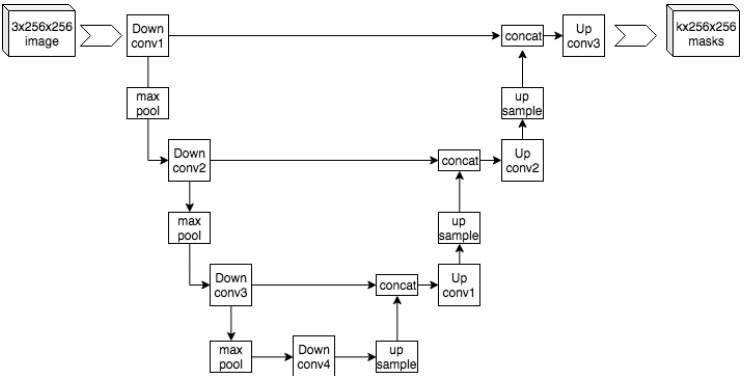
Figure 4. The structure of a UNet model similar to the original one proposed in [17]. Image distributed under a CC BY-SA 4.0